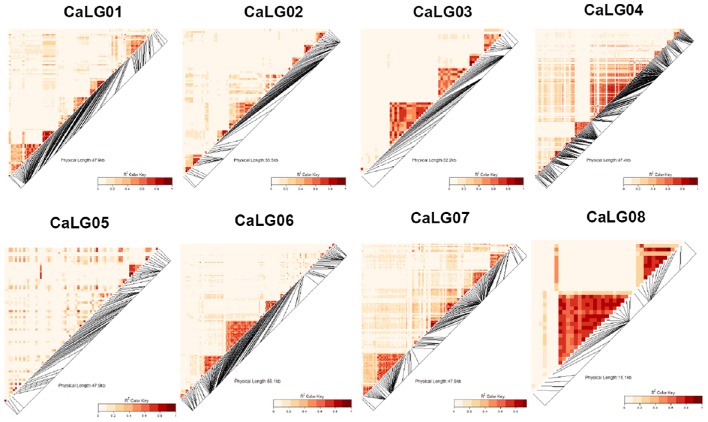
Genome-wide LD heat map constructed using SilicoDArTs and DArT-SNP markers across the 315 elite lines of chickpea. Linkage disequilibrium was calculated using r2 = 0.2 as threshold. Genome-wide LD extend up to 500–2500 kb in CaLG02 and CaLG04. One huge LD block on CaLG04 was observed.